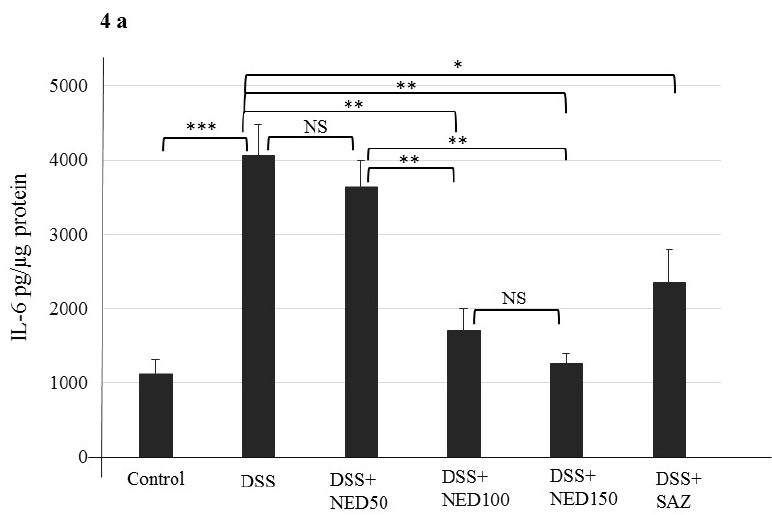
Figure 3. Effect of NED on colon histology. ( a ) Microscopic analysis shows typical architecture of the colon with normal thickness of the submucosa, muscle layer and regular crypt and villi structure in the mucosa in the control samples (Scale Bars: 100 μ M). The DSS ‐ induced colitis colon section shows focal loss of crypts and surface epithelium with inflammation reaching up to the submucosa. NED ‐ treatment, at 100 and 150 mg/kg, protected the microscopic architecture in DSS ‐ induced colitis. Crypt distortion score and colon inflammation scores were high in DSS ‐ induced colitis group. NED treatment at 100 and 150 mg/kg significantly reduced both colon inflammation scores ( b ) and crypt distortion ( c ). The lowest concentration of NED (50 mg/kg) had no effect. Data were obtained from n = 8 animals in each group and are expressed as means ± SEM. *** p ≤ 0.001. ** p ≤ 0.01. * p ≤ 0.05. p values were obtained by one ‐ way ANOVA followed by Tukey’s multiple comparison test using SPSS software. p ≤ 0.05 was considered statistically significant, and NS indicates not